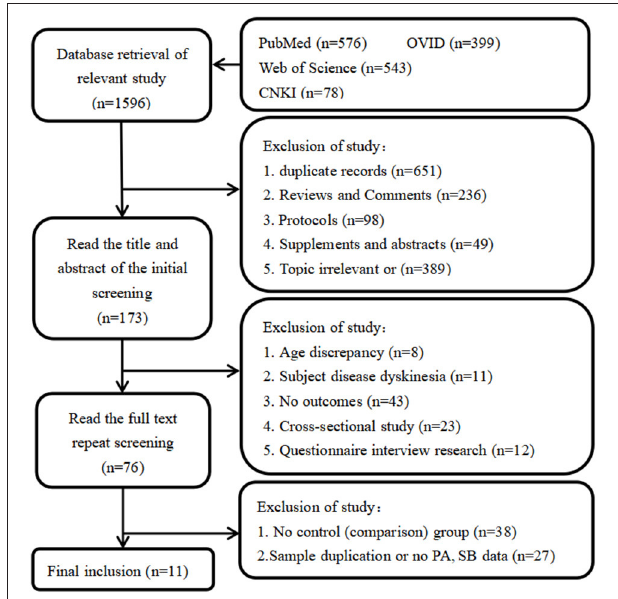
FIGURE 1 | Article selection flow chart for the